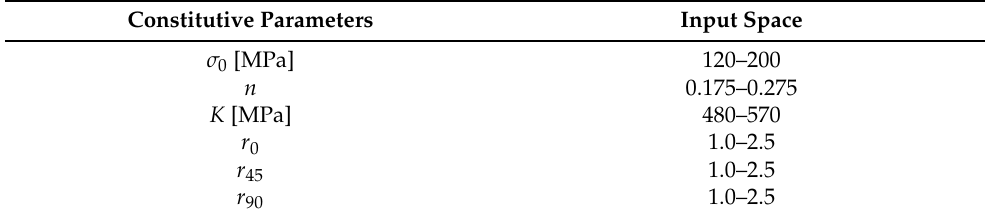
Table 2. Due to the large number of possible combinations, the Latin hypercube sampling method was used, resulting in a total of 6000 samples. Table 2. Input space of constitutive parameters for the biaxial